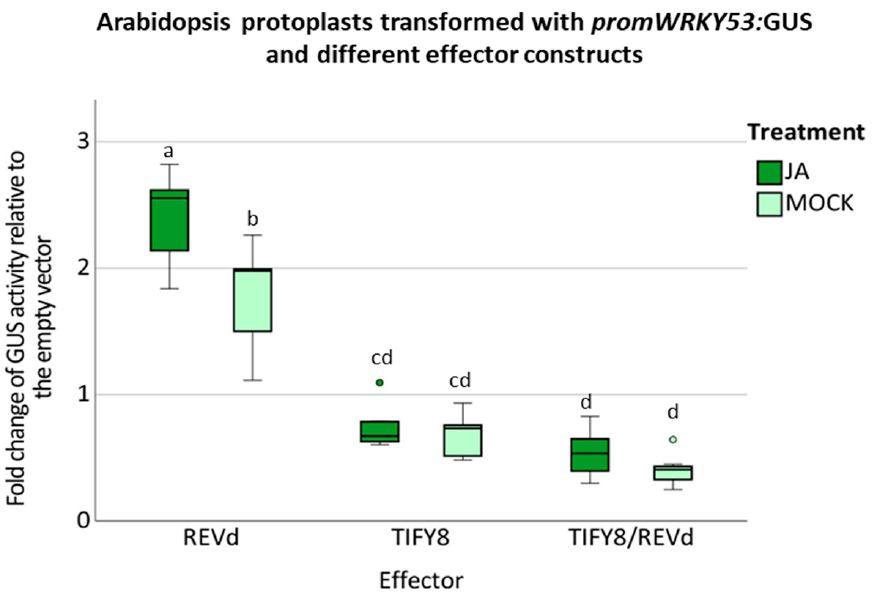
Figure 3. Arabidopsis protoplasts were transiently transformed with a 2.8-kbp-fragment of the WRKY53 promoter fused to the GUS gene as a reporter construct; 35S: REVd and 35S: TIFY8 constructs were used as effector plasmids. These transfected protoplasts were simultaneously incubated with 40 µM JA or the same volume of water for the MOCK condition. A boxplot of the values relative to the empty vector control is presented ( n = 7). One-way ANOVA test was performed, lowercase letters indicate significant differences among groups ( p ≤ 0.05).